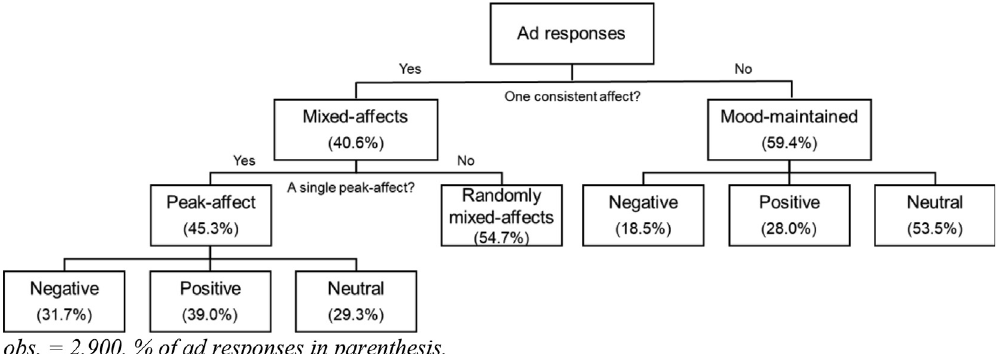
Fig. 1. Classi fi cation and frequency (%) of ad